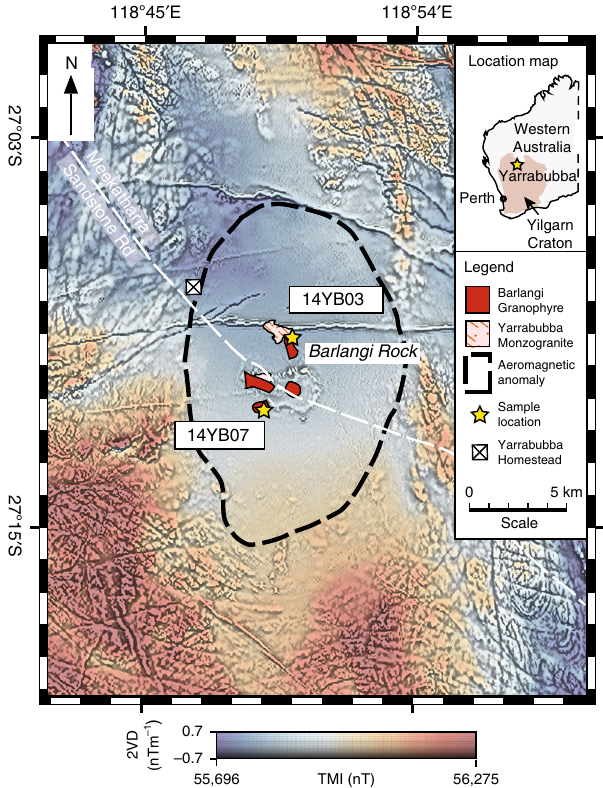
Fig. 1 Map of the Yarrabubba impact structure and sample localities. Composite aeromagnetic anomaly map of the Yarrabubba impact structure within the Yilgarn Craton, Western Australia, showing the locations of key outcrops and samples used in this study. The image combines the total magnetic intensity (TMI, cool to warm colours) with the second vertical derivative of the total magnetic intensity (2VD, greyscale) data 81 . The demagnetised anomaly centred on the outcrops of the Barlangi granophyre is considered to be the eroded remnant of the central uplift domain, which forms the basis of the crater diameter of 70 km 18 . Prominent, narrow linear anomalies that cross-cut the demagnetised zone with broadly east-west orientations are ma fi c dykes that post-date the impact